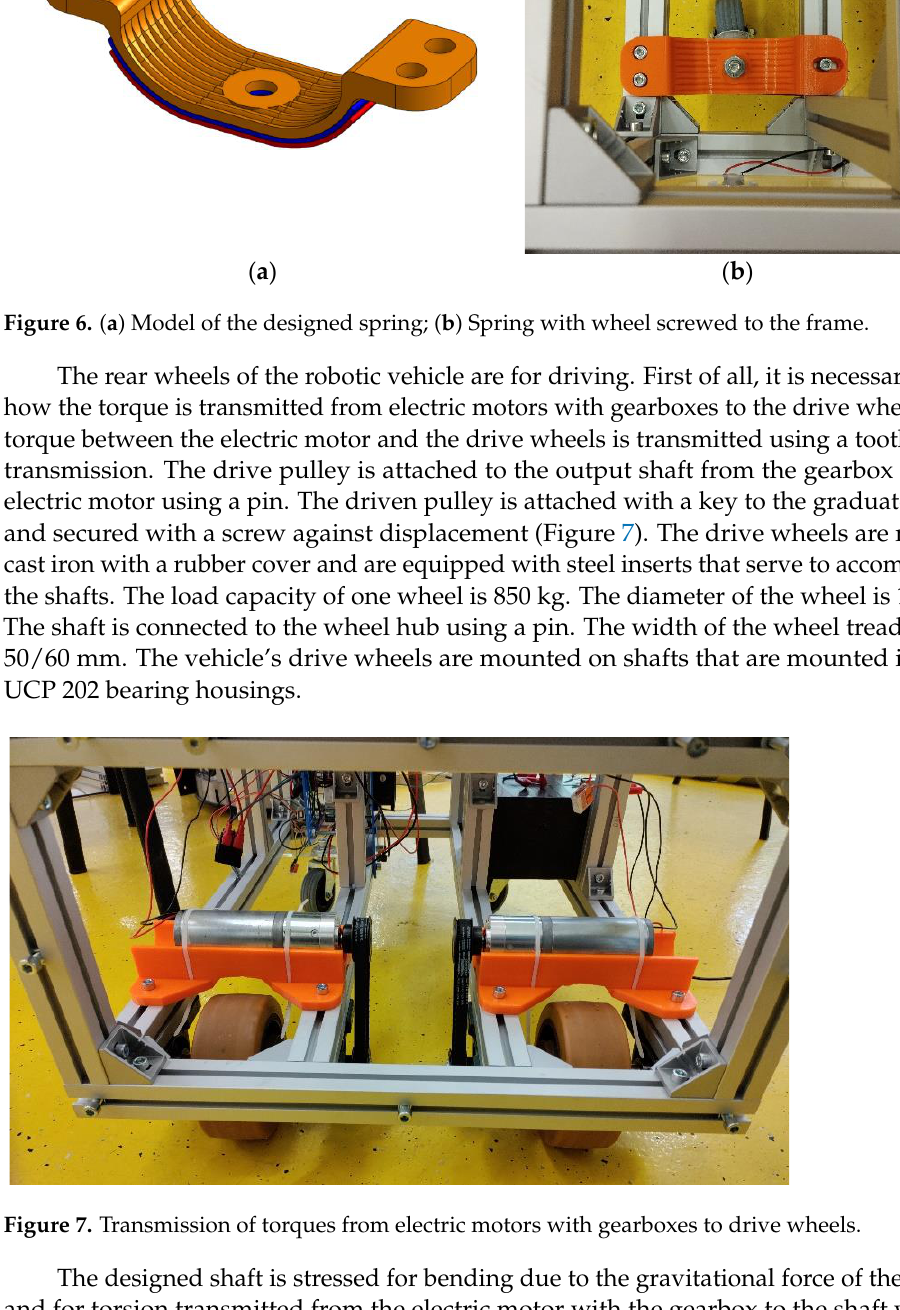
Figure 8. Loaded shaft with marked sections (Legend: G — heaviness, F BD — force from the belt drive, R A — reaction, R B — reaction, I. – IX. — marked sections). When checking the torsional stress of the shaft, the torque is calculated and the small- est cross-section is checked. The torque is calculated for the power of the electric motor P = 100.404 W and the calculated speed of the driving wheel from the speed of the electric motor and the gear ratio is n = 6.45 s −1 . The efficiency of the gearbox is η p = 90%. The torque is given by the relation in the form 𝑀 𝑘 = 𝑃 ∙ 𝜂 𝑝 2 ∙ 𝜋 ∙ 𝑛 = 100.404 ∙ 0.9 2 ∙ 𝜋 ∙ 6.45 = 2.227 Nm, (26) where M k — torque (Nm), P — electric motor power (W), η p — efficiency of the gearbox (1), n — drive wheel rotation (s −1 ). The results of the calculated values of bending stresses and torsional stresses in indi- vidual sections are shown in Table 5.